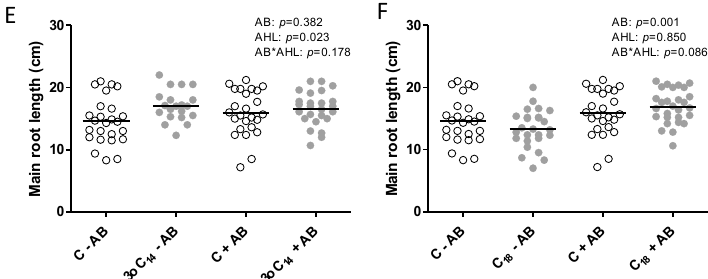
Figure 3. Root length of M. truncatula plants exposed to 1 µ M AHLs and inoculated with rhizobia, measured at 21 days after inoculation. Plants were treated with (grey) or without (white) ( A ) C 4 -HSL, ( B ) C 8 -HSL, ( C ) 3-oxo-C 8 -HSL, ( D ) C 14 -HSL, ( E ) 3-oxo-C 14 -HSL, or ( F ) C 18 -HSL. The control treatments (‘C’) included the same dilution of the solvent as the AHL treatments. Different letters indicate significant differences between the treatments when the interaction is significant (REML test p < 0.05). No post hoc test when the interaction is not significant. AB: antibiotic treatment. Lateral root density was not affected by any of the AHLs, with a minor effect of the AB treatment in the C 18 -HSL-treated plants (Figure 4).